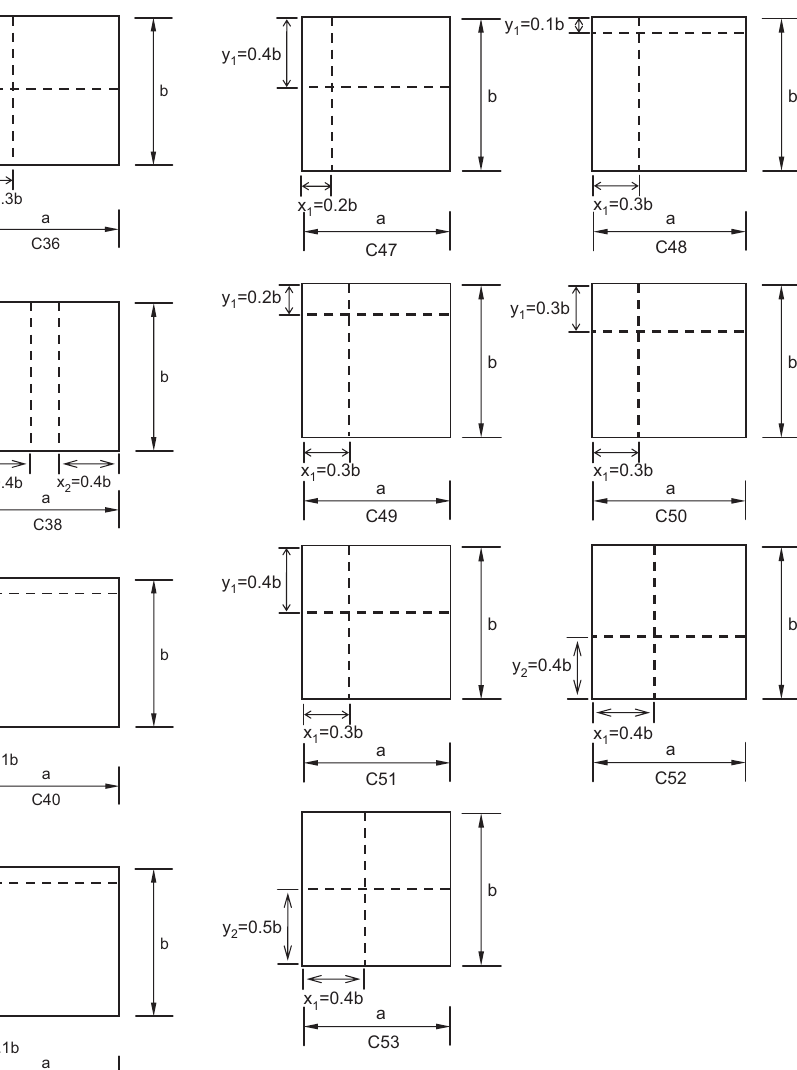
Figure 5 Fifty-three different combinations of laminated plates with one or two intermediate line